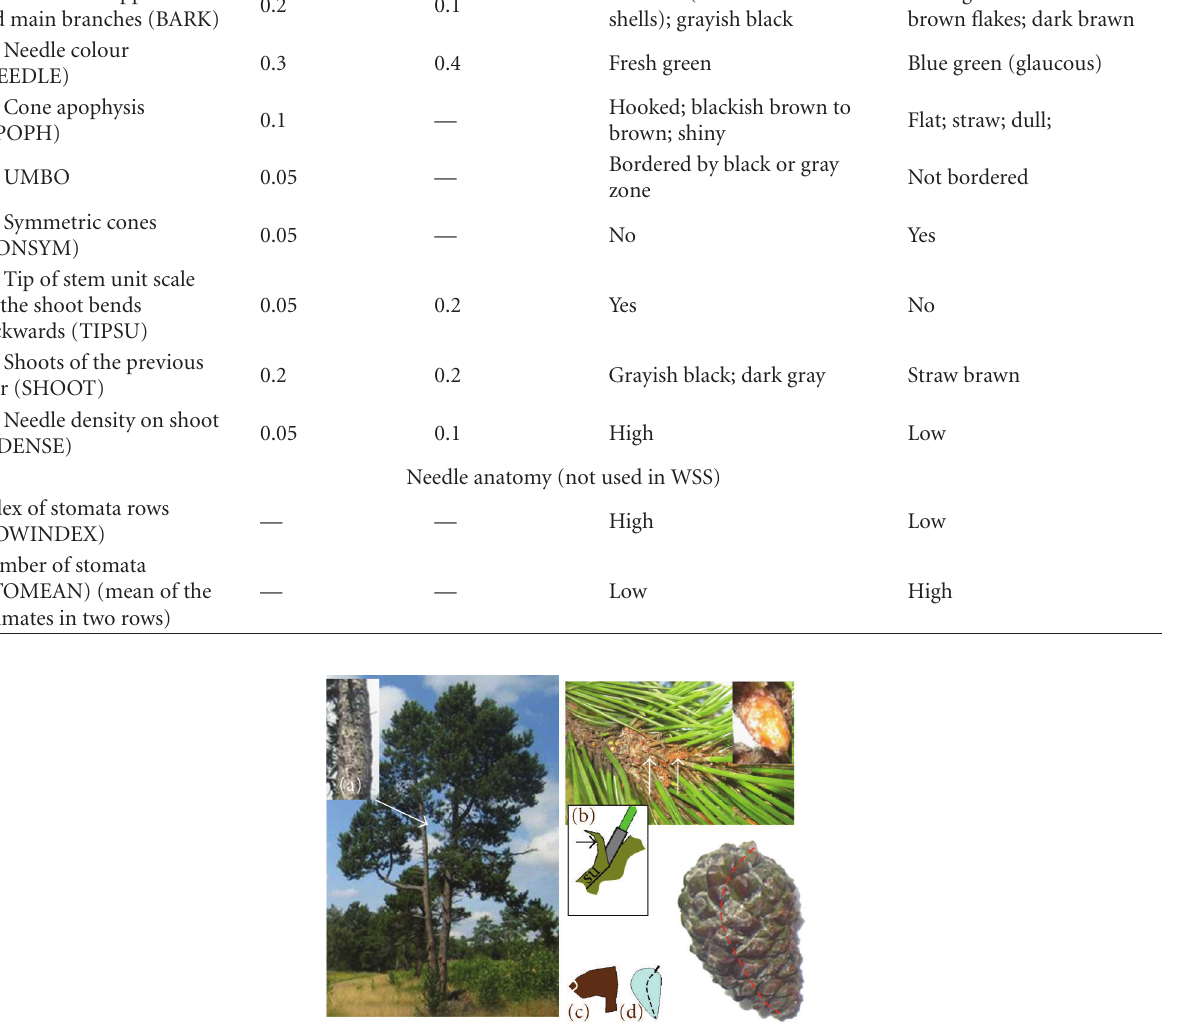
Figure 2: Key morphological traits of P. mugo subs. uncinata. Left: 12 meter tall tree, erect growth (resembling well P. sylvestris, but distinguishing P. mugo subsp. uncinata from P. mugo subsp. rotundata and subsp. mugo ) needles fresh green, (a) upper stem dark grey, no reddish brawn peeling o ff paper flakes. Upper right: shoots dark grey with tip of bark of the stem unit prolonged and bending backwards at the base of the needle sac (b); buds are oval at the top; needles are densely attached. Lower right: cone scales are hooked (c) and cones asymmetric (d), apophysis glossy, umbo